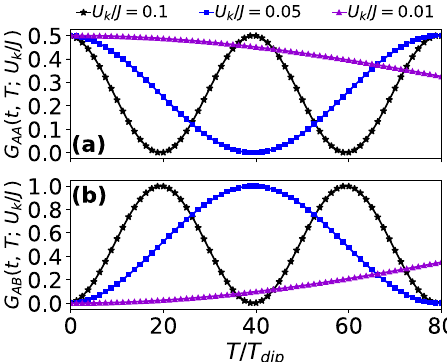
Fig. 8 Output correlations in the analog Ramsey setup at fi xed t . a Behavior of the auto-correlation G AA ( t , T ; U k / J ) as a function of T / T dip , for t / T dip = 0.5, and for different values of U k / J . b Behavior of the cross- correlation G AB ( t , T ; U k / J ) as a function of T / T dip , for t / T dip = 0.5, and for the different values of U k / J . In both panels, the different curves correspond to the values of U k / J speci fi ed in the